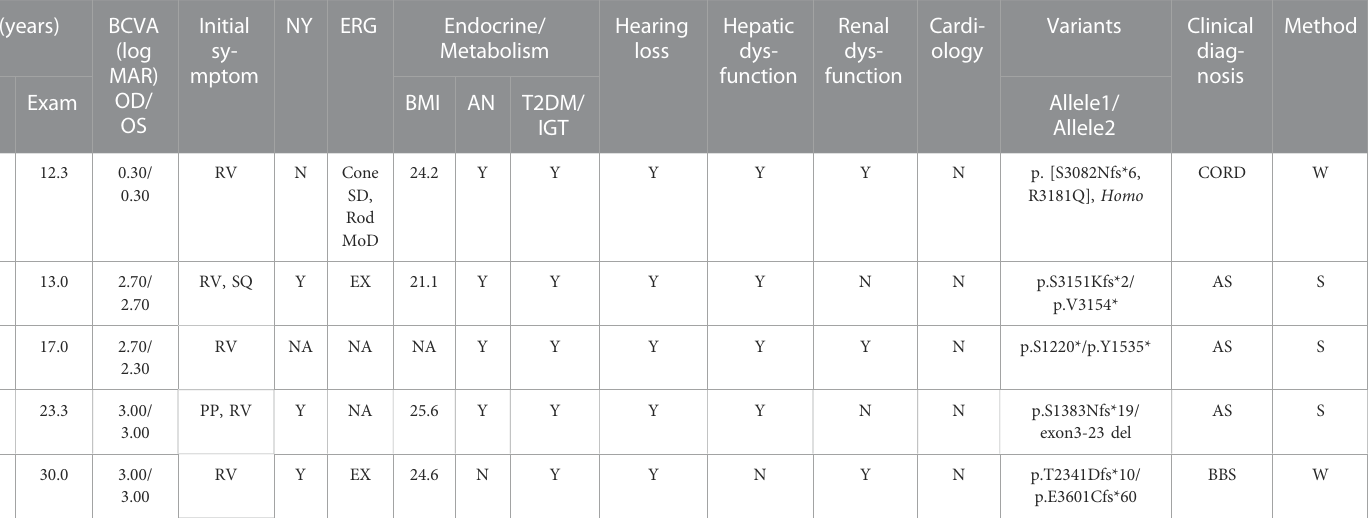
TABLE 2 ( Continued ) The Clinical features and results of the ALMS1 gene variants screening of the